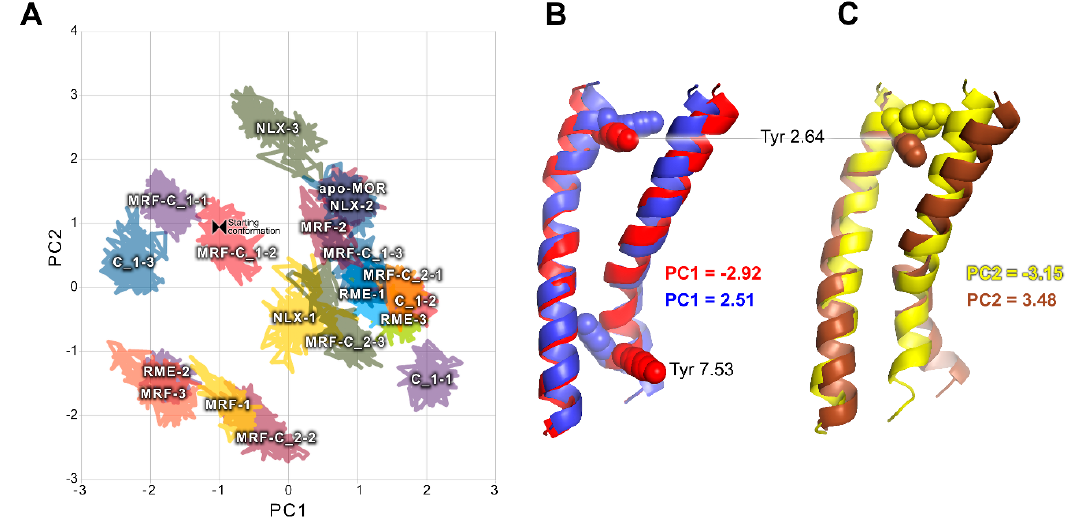
Figure 7. Joint PCA of TM2 and TM7. ( A ) Conformational space occupied by investigated complexes through last 50 ns of simulations in a common space exhibits large similarity to PCA calculated for TM7 alone. ( B ) Projections of extreme PC1 values on trajectories. Color-coding of the legend corresponds to colors of the helices. ( C ) Projections of extreme PC2 values on trajectories. Color-coding of the legend corresponds to colors of the helices.